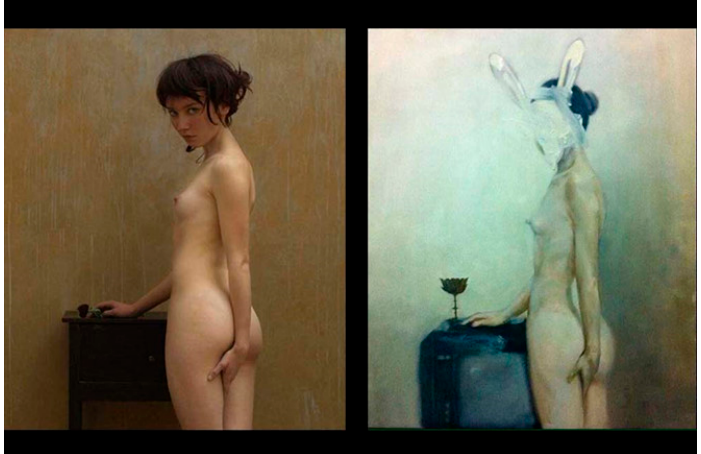
Figure 11. ( Left ) The French artist’s painting. ( Right ) Co gai tho—Nguyen Phan Bach. The image was sourced from Thanh Nien Newspaper (Nguyen 2017a).